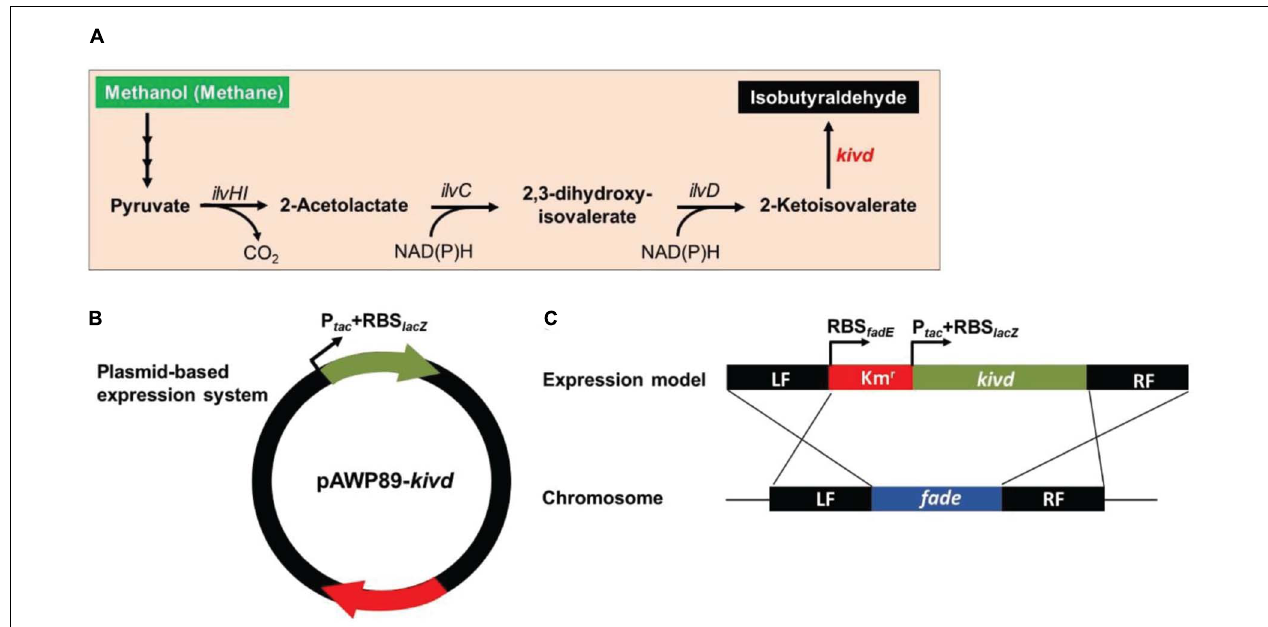
FIGURE 2 | Framework of the heterologous expression of 2-ketoisovalerate decarboxylase (KivD) in strain Methylomicrobium buryatense 5GB1S. (A) Artificial pathway for isobutyraldehyde production from methanol or methane in strain M. buryatense 5GB1S. (B) Scheme of the plasmid-based expression of the foreign gene kivd in strain M. buryatense 5GB1S. (C) Scheme of the integration of the foreign gene kivd into the chromosome of strain M. buryatense 5GB1S. Word in red represents an exogenous gene. Words in black represent endogenous genes. These genes coded for acetohydroxyacid synthase ( ilvHI ), acetohydroxyacid isomeroreductase ( ilvC ), and dihydroxyacid dehydratase ( ilvD ). Intersecting lines indicate homologous recombination. LF , left flanking region; RF , right flanking region.